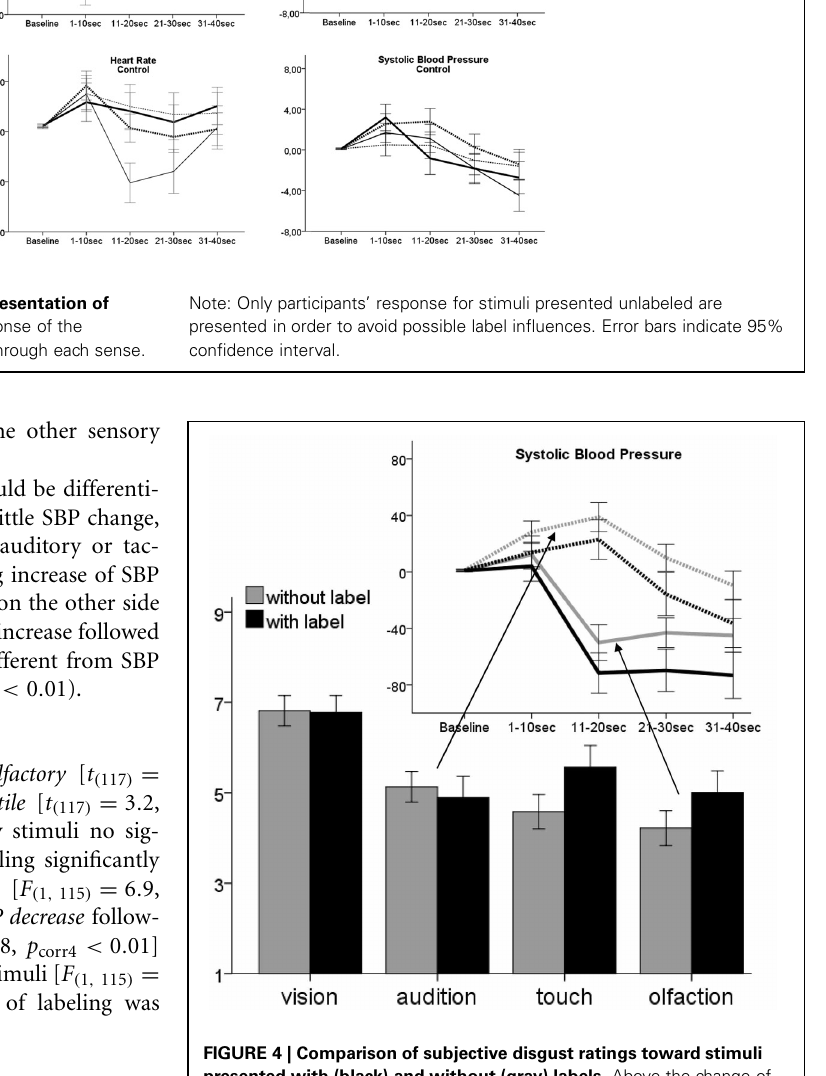
FIGURE 4 | Comparison of subjective disgust ratings toward stimuli presented with (black) and without (gray) labels. Above the change of systolic blood pressure for auditory (dashed lines) and olfactory stimuli in the presence of label (black) is shown. Ratings are given on a 9-point scale, SBP in AuC intervals. Error bars indicate 95% confidence